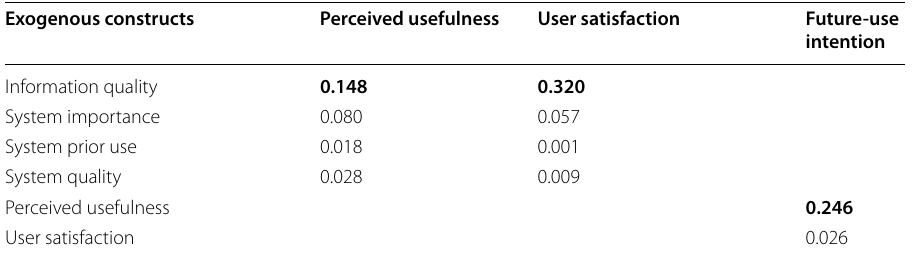
Table 9 f square effect